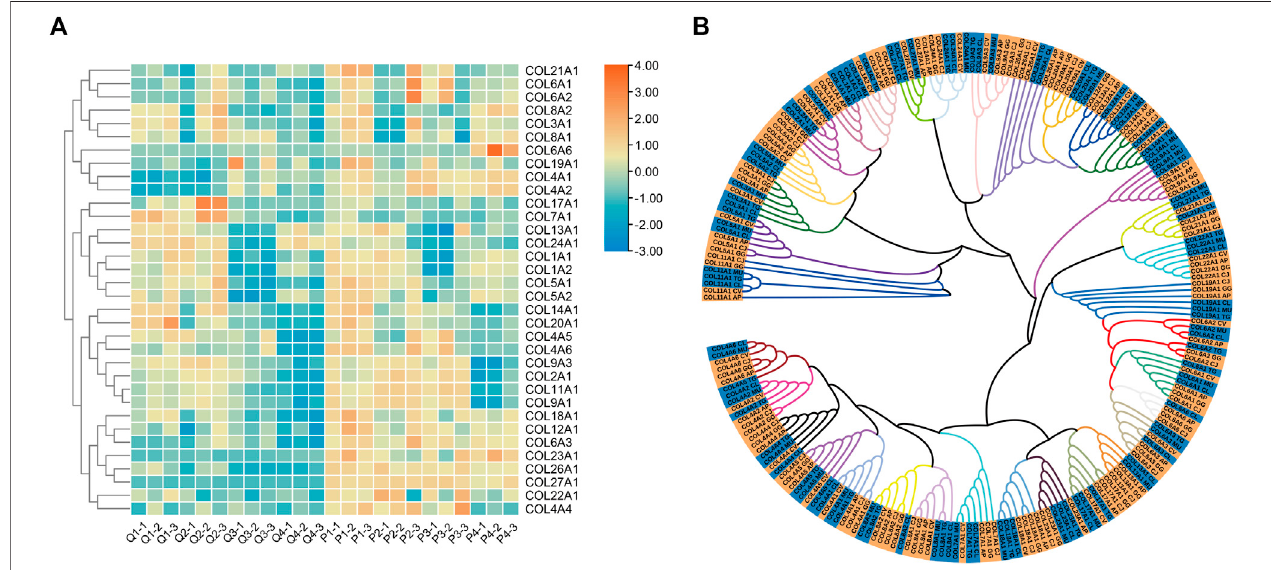
FIGURE 5 | Expression and Phylogenetic Analysis of the COL Gene Family. (A) The heat map of gene expression in the four growth stages of quails and pigeons. The expression level used in the heat map was log scale of FPKM value. (B) Phylogenetic tree of COL Gene family. Each color branch represents a gene, and the yellow and blue highlights at the end of the branch are precocial and altricial bird species, respectively. AP: Anas platyrhynchos (Duck), CJ: Coturnix japonica (Japanese quail), GG: Gallus gallus (Chicken), CV: Charadrius vociferus (Killdeer), CL: Columba livia (Pigeon), MU: Melopsittacus undulatus (Budgerigar), TG: Taeniopygia guttata (Zebra fi